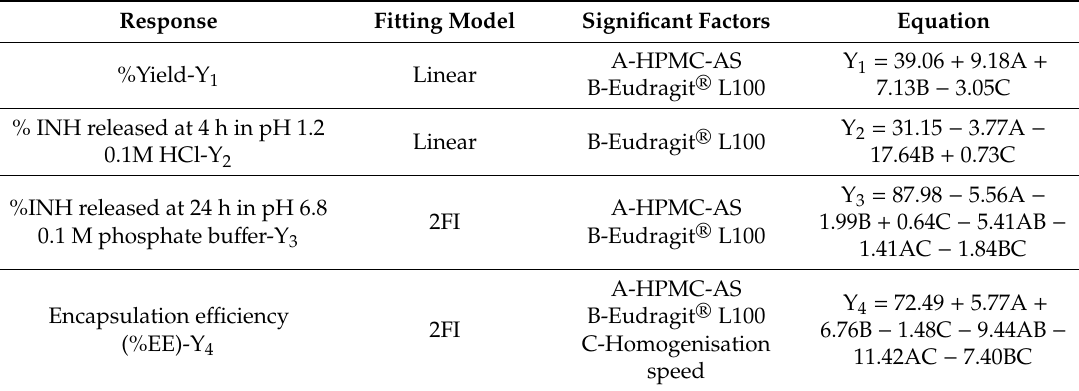
Table 7. Summary of best fit models, significant factors, and equations describing the relationship between input variables and response for INH microspheres.